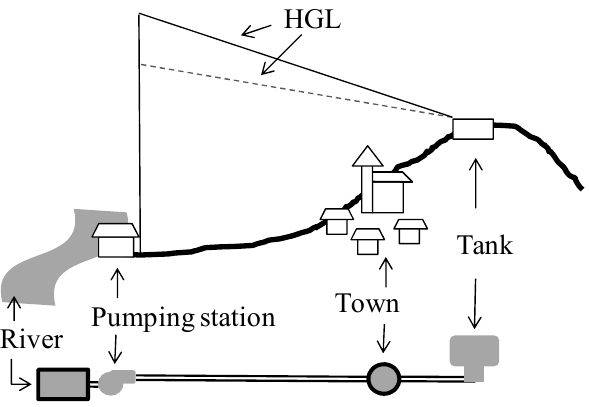
Figure 5. Case study layout and its EPANET representation. The hydraulic grade line (HGL) of the pump run at reduced speed (dashed line) has a flatter slope than the HGL at full speed (con- tinuous